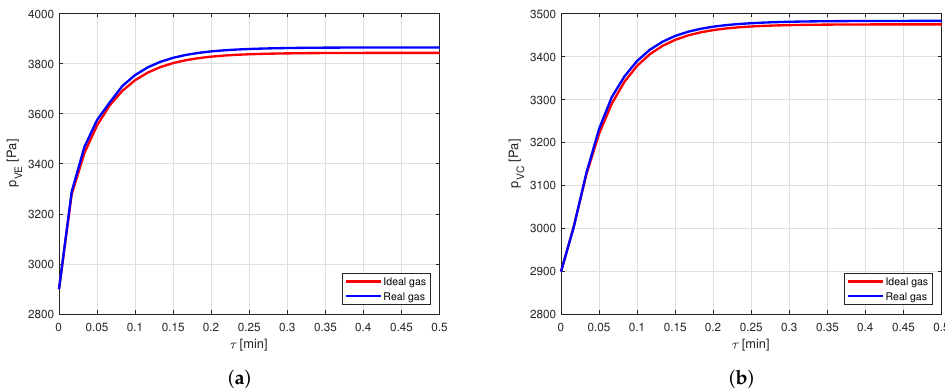
Figure 10. Comparison between the vapor pressures obtained by modeling the vapor as ideal or real gas, in a copper-water heat pipe. ( a ) Comparison of the vapor pressures at the evaporator. ( b ) Comparison of the vapor pressures at the